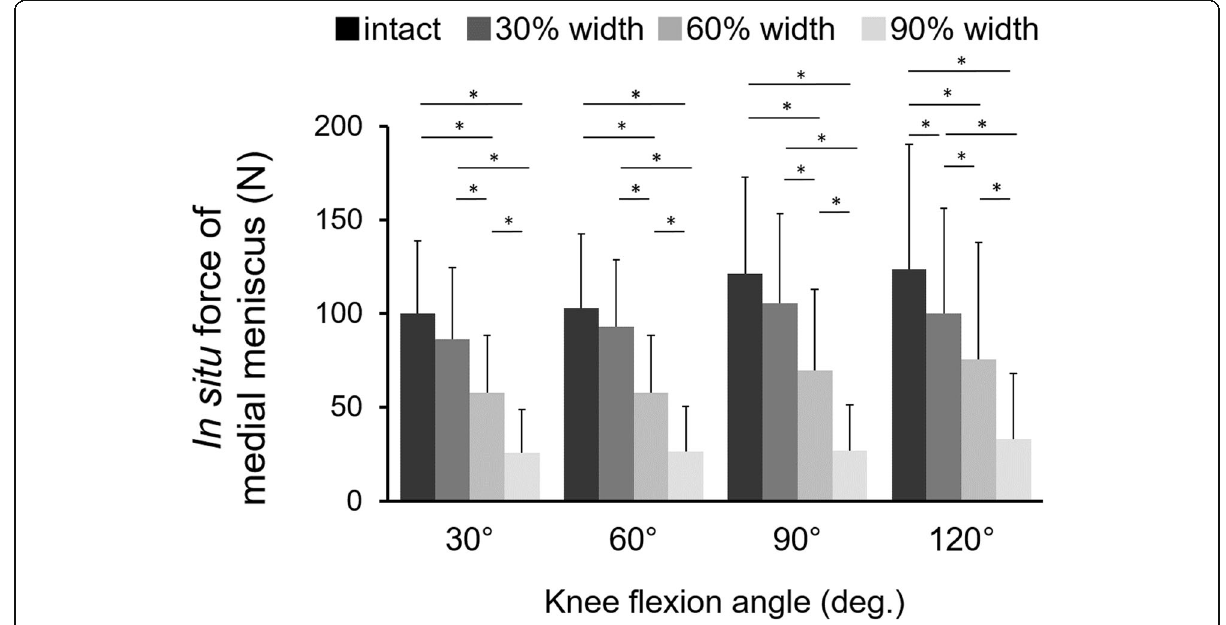
Fig. 5 In situ forces of the medial meniscus under an axial load of 300 N. *: significant difference ( p <